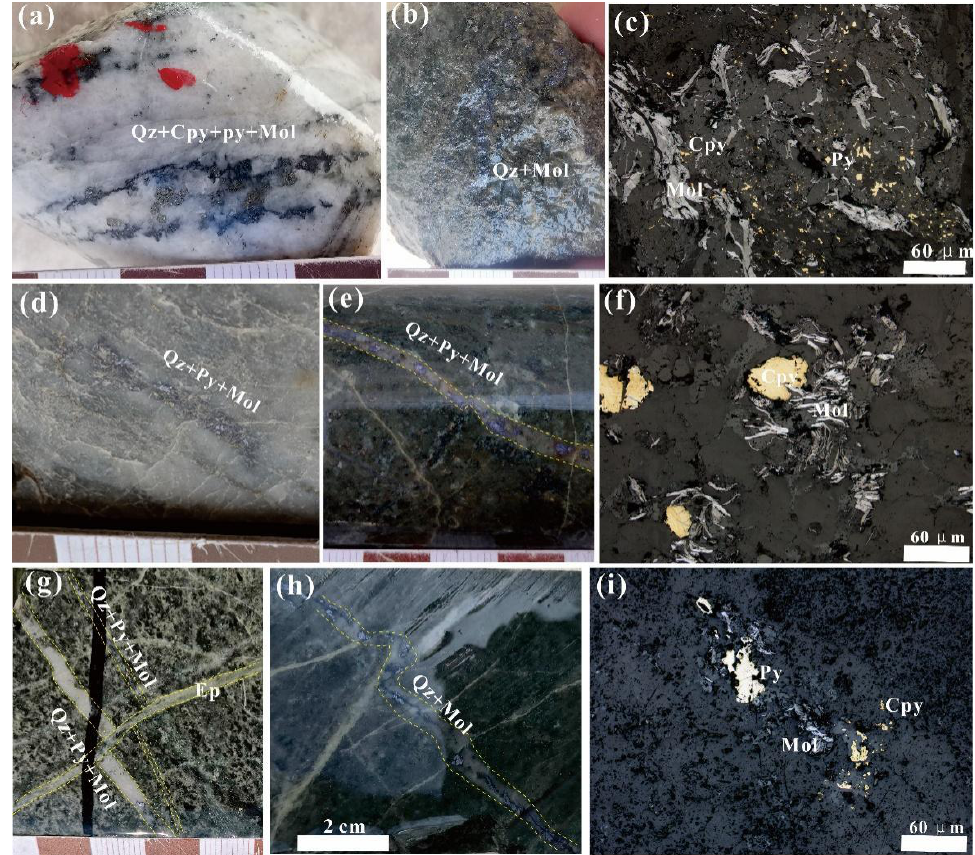
Figure 6. Photographs and photomicrographs of ore samples from the Tuwu – Yandong porphyry Cu belt. ( a ) Quartz – chalcopyrite – pyrite – molybdenite vein in Cu – Mo ore from the Tuwu deposit; ( b ) quartz – molybdenite vein-type mineralization of the Tuwu deposit; ( c ) molybdenite with the feature of leaden, coexist with chalcopyrite and pyrite (reflected light) in Cu – Mo ore from the Tuwu deposit; ( d ) quartz – pyrite – molybdenite vein in silicified porphyry from the Linglong deposit; ( e ) quartz – pyrite – molybdenite vein in propylitic basalt from the Linglong deposit; ( f ) molybdenite coexist with chalcopyrite (reflected light) in Cu – Mo ore from the Linglong deposit; ( g ) two quartz – pyrite – molybdenite veins cut by epidote vein in mineralized porphyry from the Chihu deposit; ( h ) quartz – molybdenite vein cut by quartz veins in propylitic basalt from the Chihu deposit; ( i ) molybdenite, with leaden and fine-grained features, coexisting with chalcopyrite and pyrite (reflected light) in Cu – Mo ore from the Chihu deposit. Mineral abbreviations: Cpy, chalcopyrite; Mol, molybdenite; Py, pyrite; Qz quartz, Ep epidote.